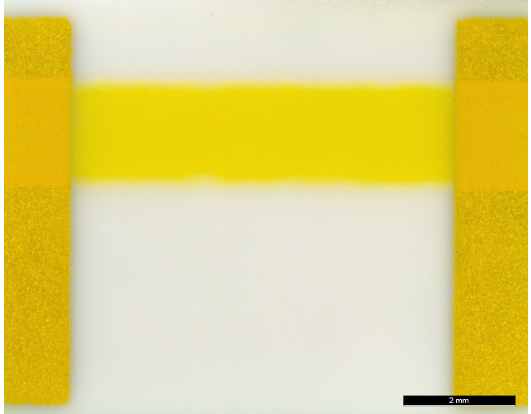
Figure 4. ITO thick film resistance sample, light-optical microscope image at 12-fold magnification. The image shows a part of the film between two of the Au contact pads, deposited on a 3YSZ substrate.